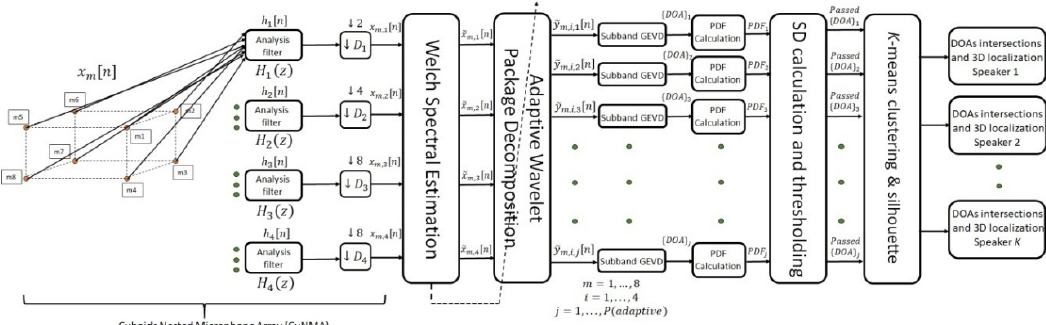
Figure 2. The block diagram of the proposed 3D SSL system based on cuboids nested microphone array (CuNMA) and subband generalized eigenvalue decomposition (GEVD) algorithm.